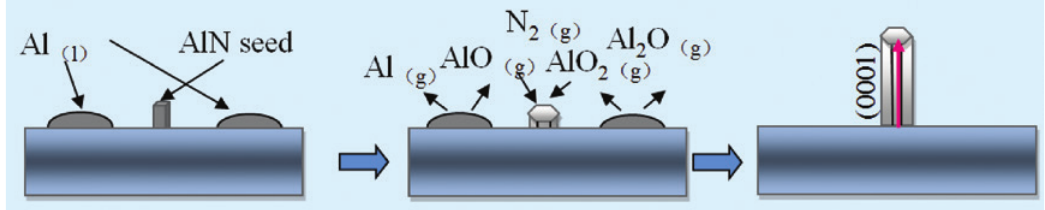
Fig. 8: The growth mechanism of AlN